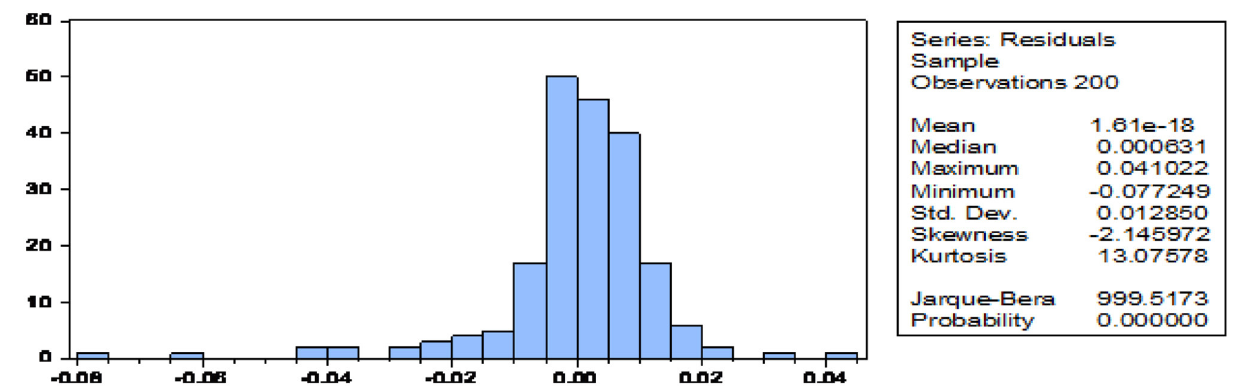
FIGURE 1 | Graphical